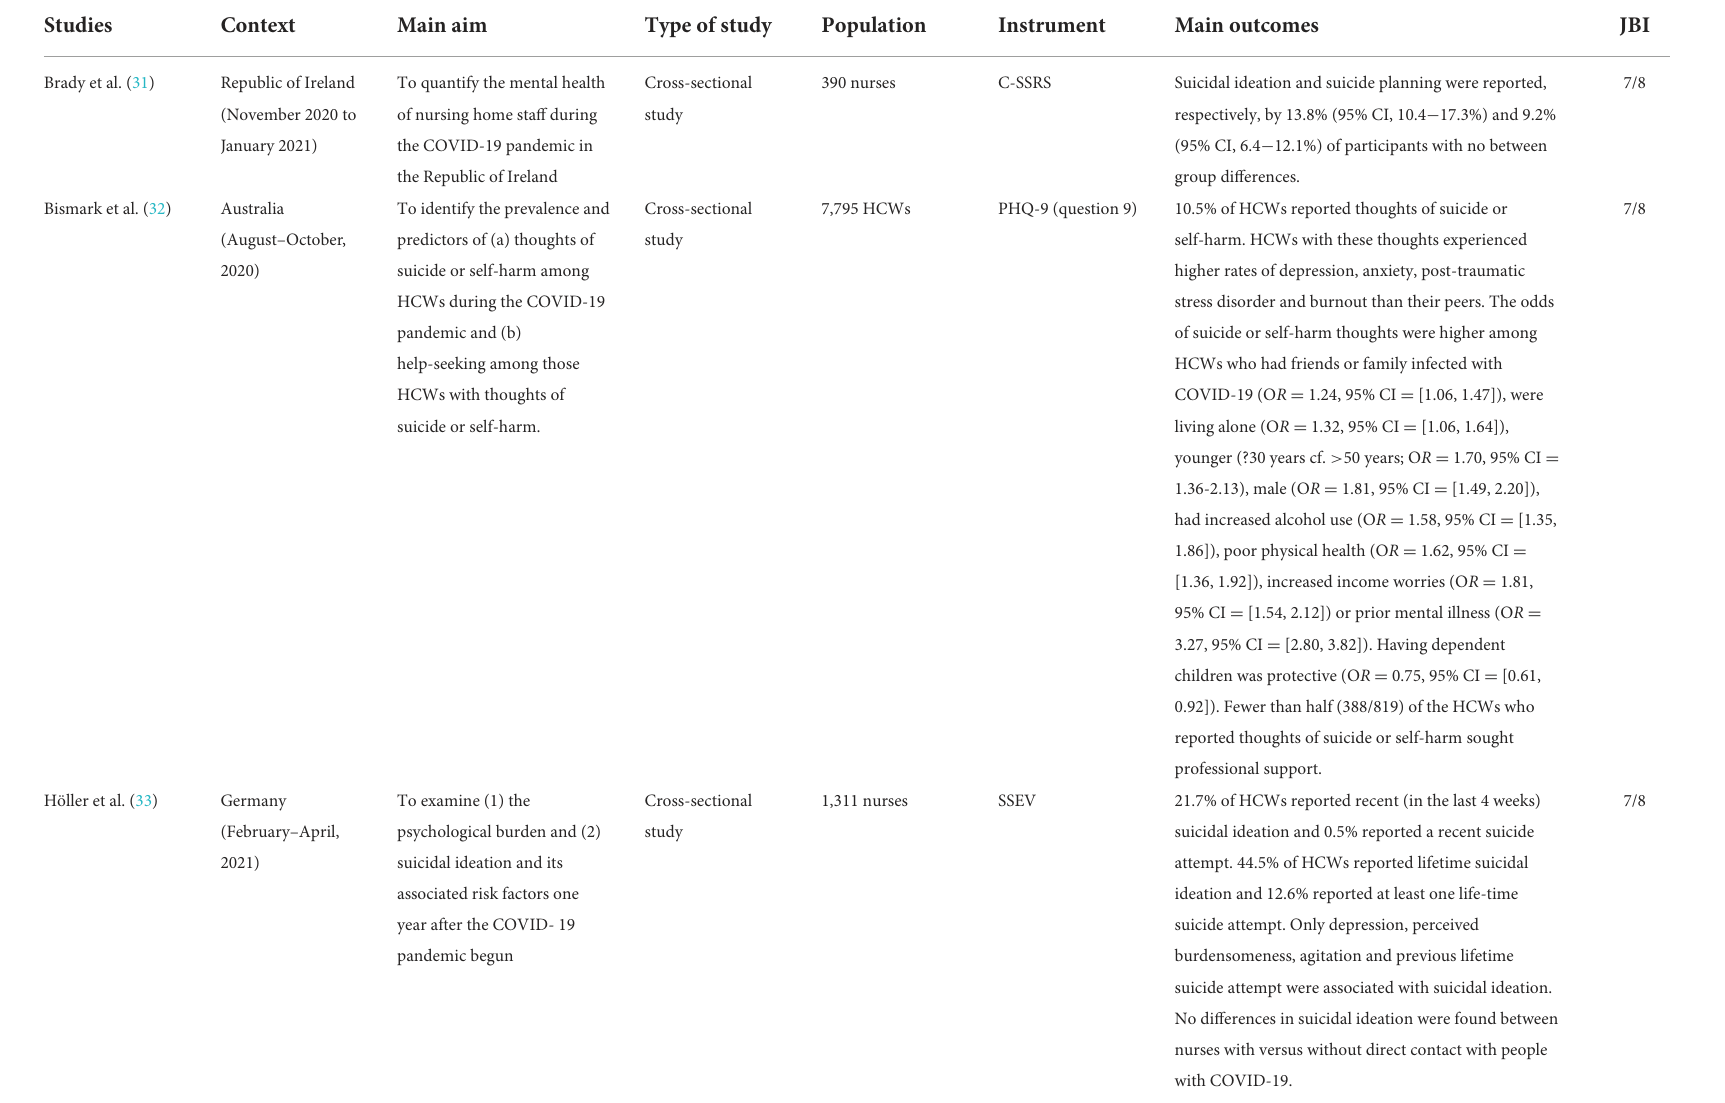
TABLE 4 Characteristics of the studies included in the systematic